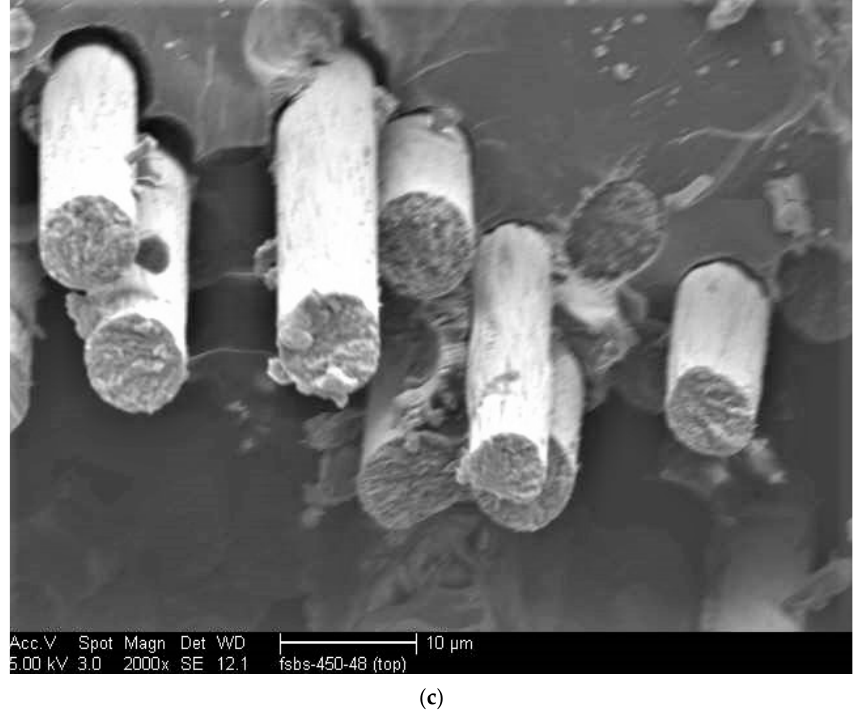
Figure 7. ( a ) SEM image of fracture of an unaged specimen. ( b ): SEM image showing debonding along with hackles on the matrix for a specimen subject to 48 h of thermal aging at 177 °C. ( c ): SEM image showing debonded areas with gaps between the fiber and matrix and clean fiber surfaces.